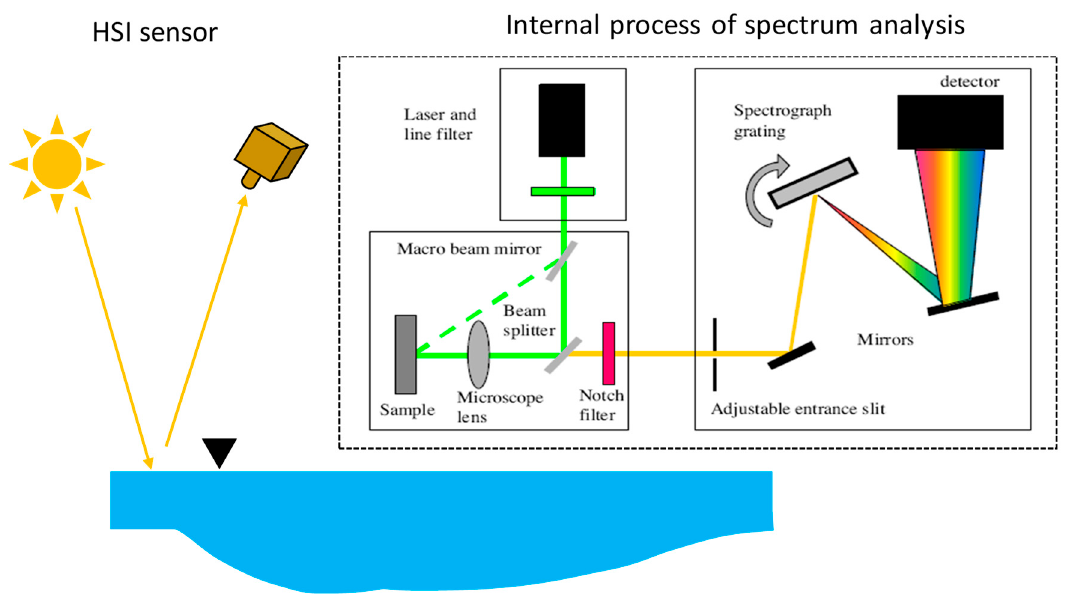
Figure 2. Schematic of a hyperspectral images (HSI) sensor system.